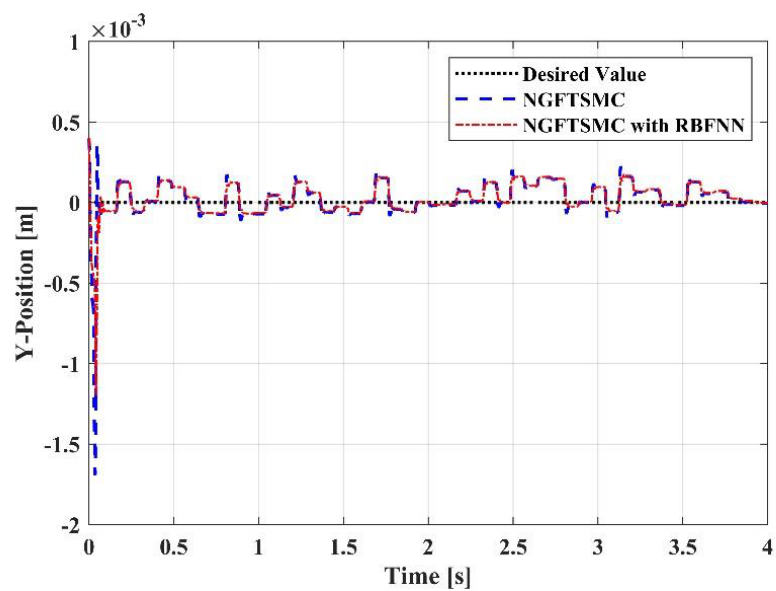
Figure 7. The trajectory tracking results in Y-Position.